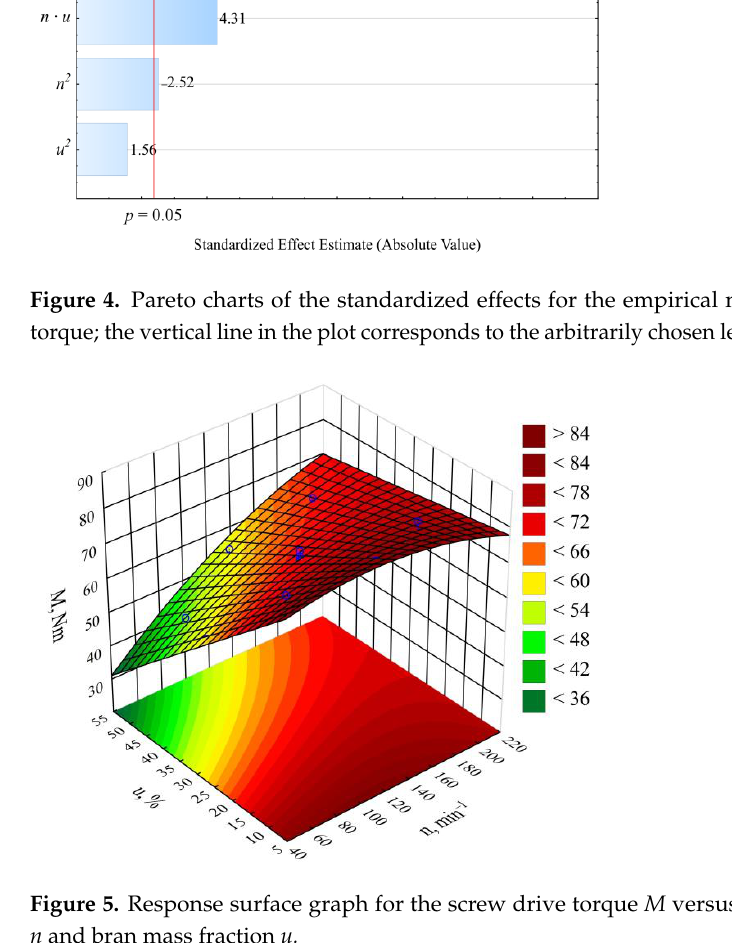
- SS — sum of squares, df — number of the degrees of freedom, MS — mean sum of squares, F — values of the test statistic, p -value of probability corresponding to the test statistic value.